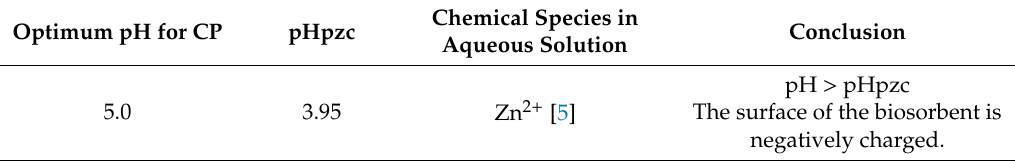
Table 6. Point of zero charge for the CP and its relation with the optimum pH.